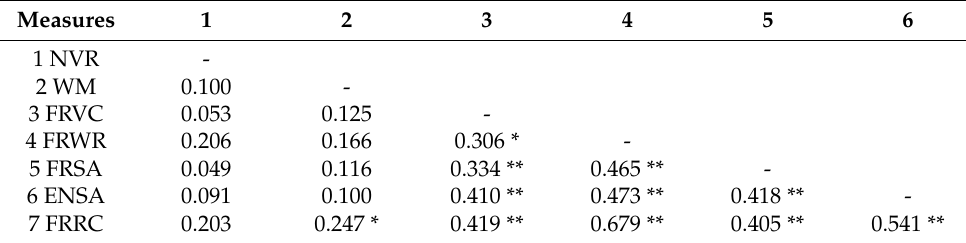
Table 2. Correlations between all measures ( n = 68).